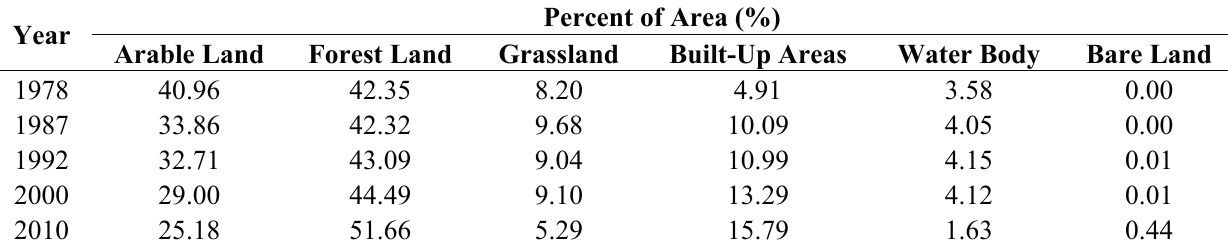
Table 4. 1978–2010 land use and land cover statistics in Beijing, China.